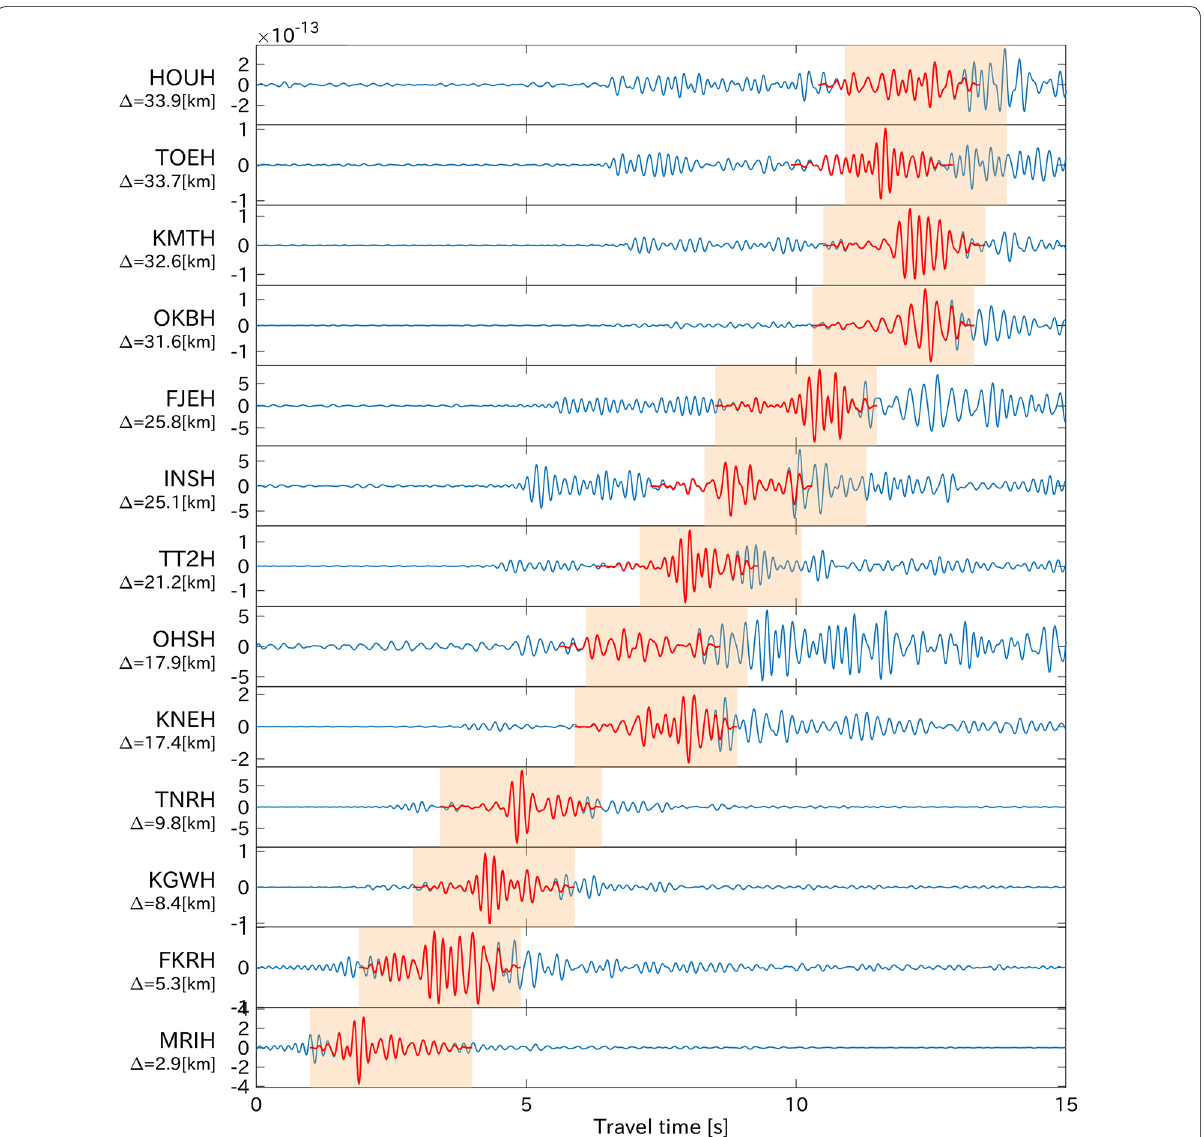
table. Red lines show the reference wave that we